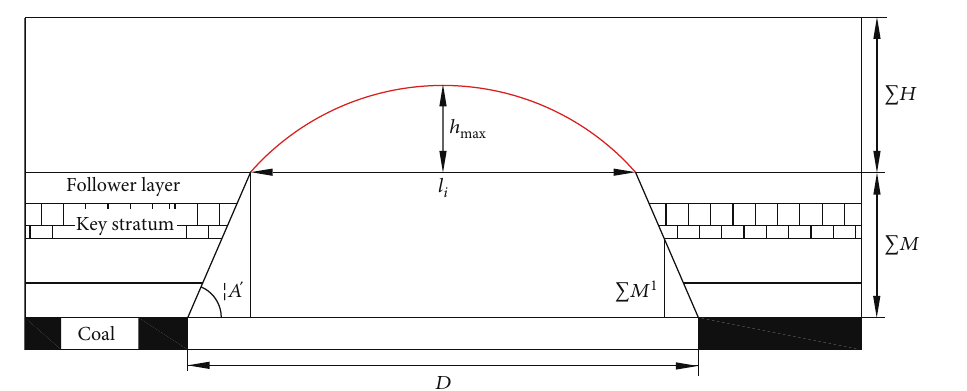
Figure 11: Calculation diagram of l.